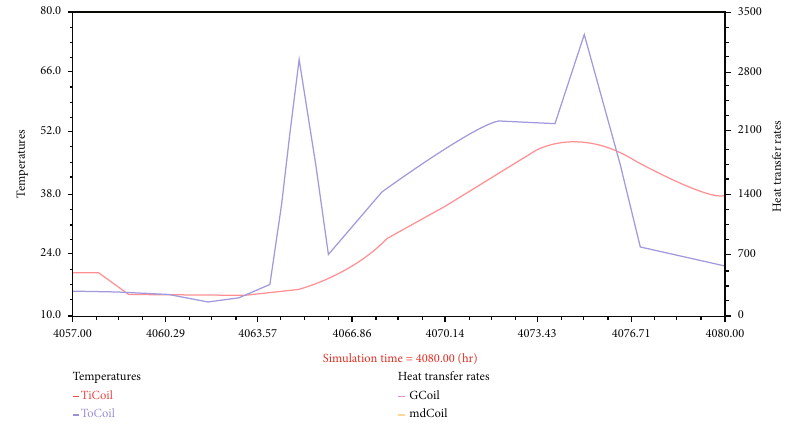
Figure 14: Comparison of collector inlet and outlet temperature in solar water heater system.